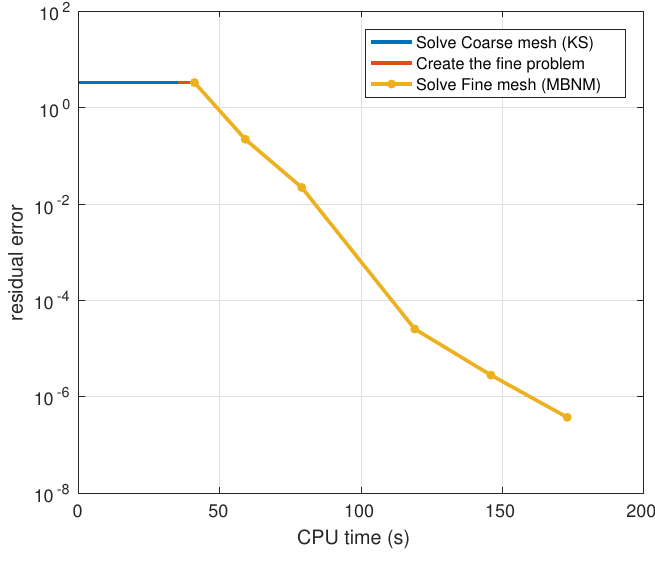
Fig. 4 CPU time of multilevel method for Ringhals reactor with FED =